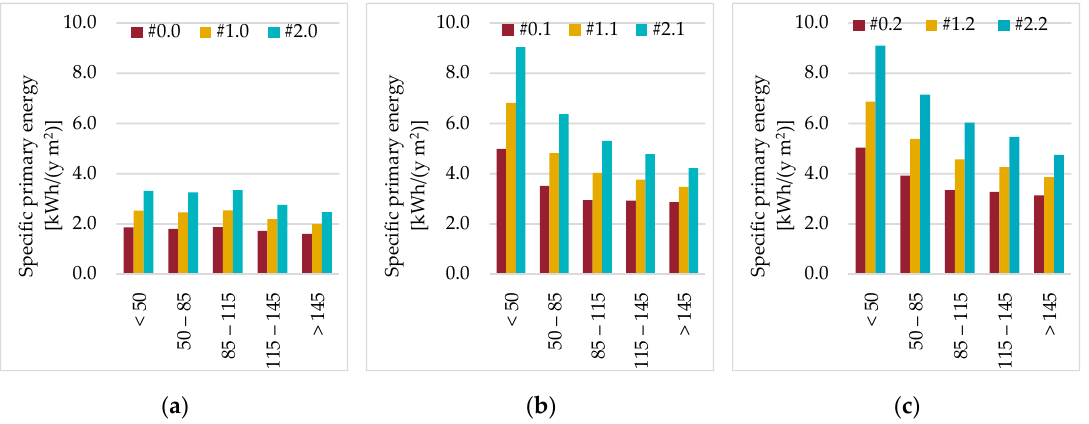
Figure 15. Florence: Specific primary energy consumption for cooling. ( a ) Existing equipment; ( b ) existing equipment + 1 air conditioner; ( c ) existing equipment + 2 air conditioners.